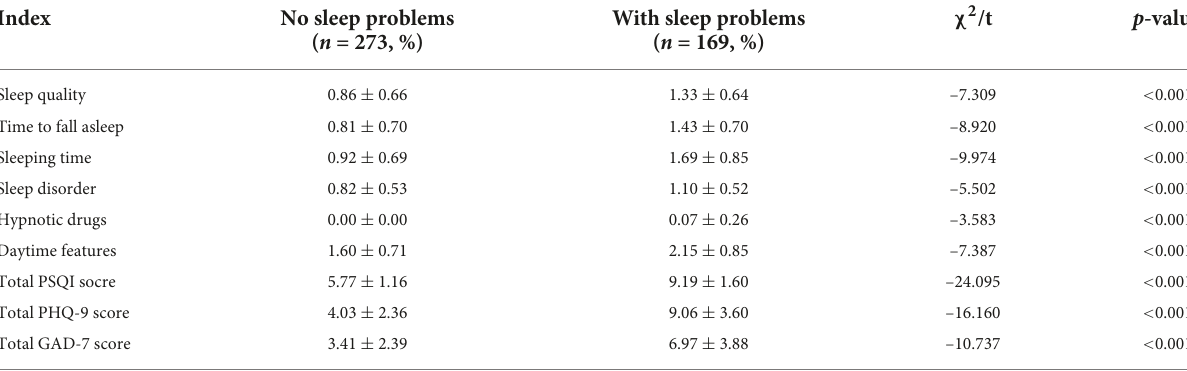
TABLE 3 Comparison of scores of sleep quality, depression, and anxiety among people with and without sleep problems.